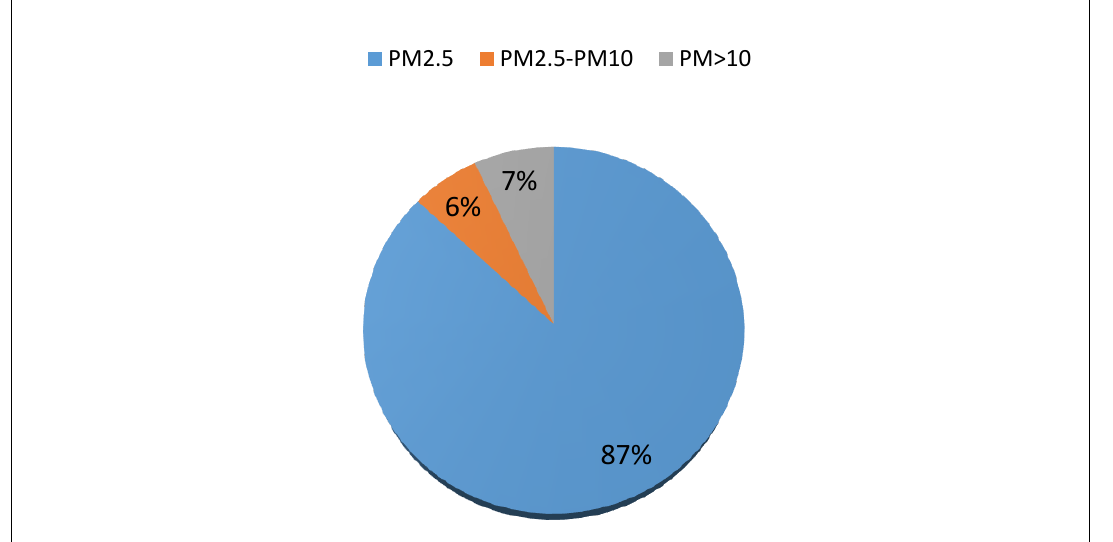
7 of 22 Figure 3. Residential PM 10 concentration from SWI, average and standard deviation. E vs. NE (ng/m 3 ). 2.5. Chemical Speciation A background PM 2.5 chemical speciation was conducted by ARPAE Emilia-Romagna in Bologna city. Since the Modena municipality is near Bologna and urban and territorial features, weather characteristics and main pollutant sources are very similar, chemical concentration data